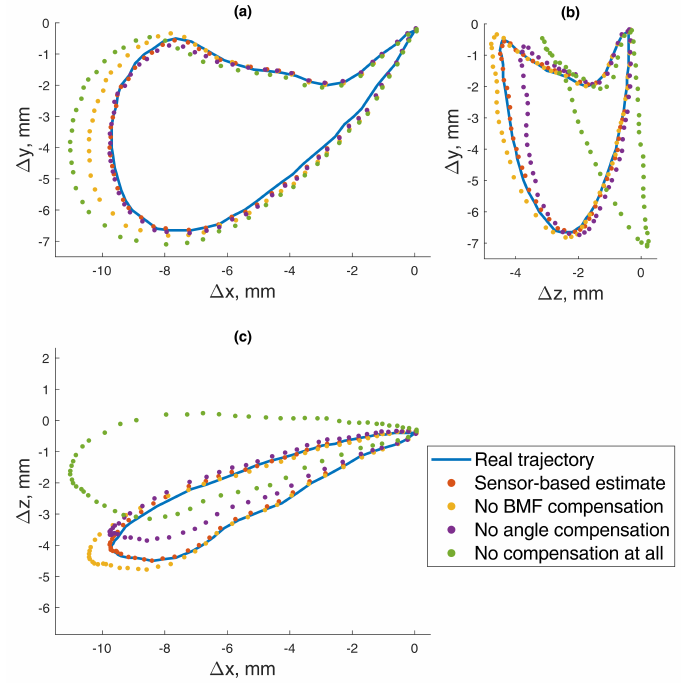
Figure 17. The 5–DOF masticatory test trajectory estimated with and without the BMF compensation and angle compensation algorithms. Magnetic values at each point recorded with the sensor in the static state. ( a ) Lateral–vertical view ( x – y ). ( b ) Protrusive–vertical view ( z – y ). ( c ) Lateral–protrusive view ( x – z